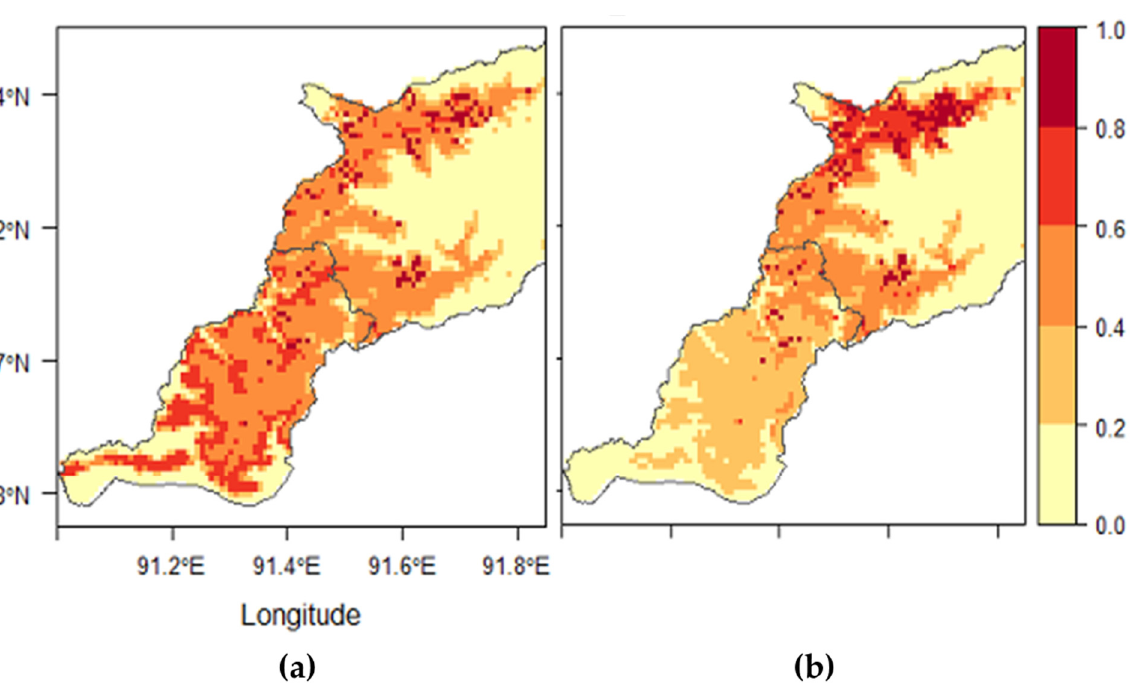
Figure 5. Habitat suitability maps developed by the best models ( a ) for Rhipicephalus microplus using land use and land cover (LULC) and digital elevation–shuttle radar topography information (DEM_SRTM) and ( b ) for Rhipicephalus haemaphysaloides using LULC, Bio 16, and Bio 10.